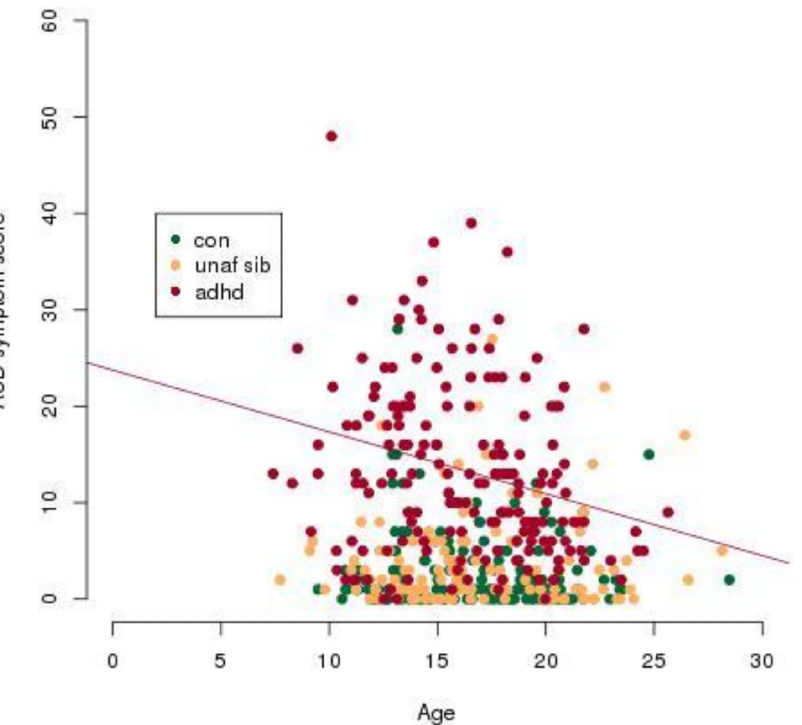
Figure 4. ASD scores decrease significantly with age within the ADHD groups. A regression line is plotted where the Pearson’s product- moment correlation is significant with p , 0.05. ASD score refers to an aggregate score from the four Children’s Social and Behavioural Questionnaire (CSBQ) subscales, (1) social interest, (2) social understanding, (3) stereotypy and (4) resistance to change. Abbreviations: con, Control; unaf sib, Unaffected Siblings, ADHD, Attention-deficit/hyperactivity disorder; ASD, autism spectrum